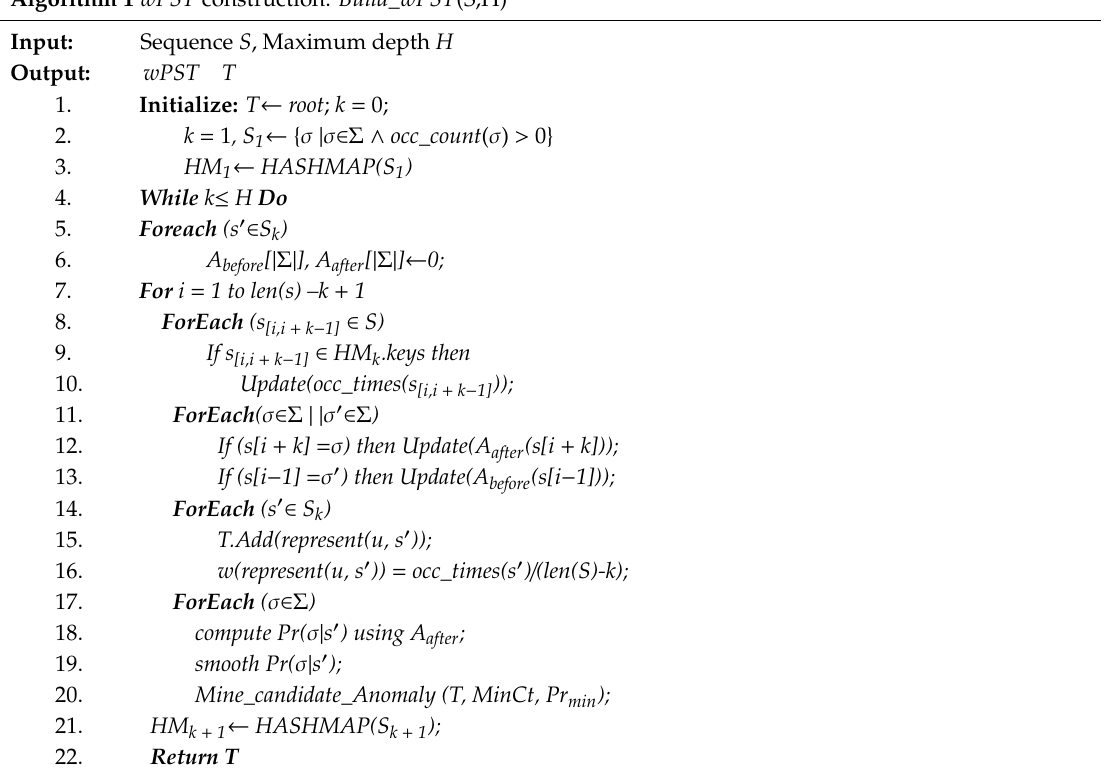
Algorithm 1 wPST construction. Build_wPST